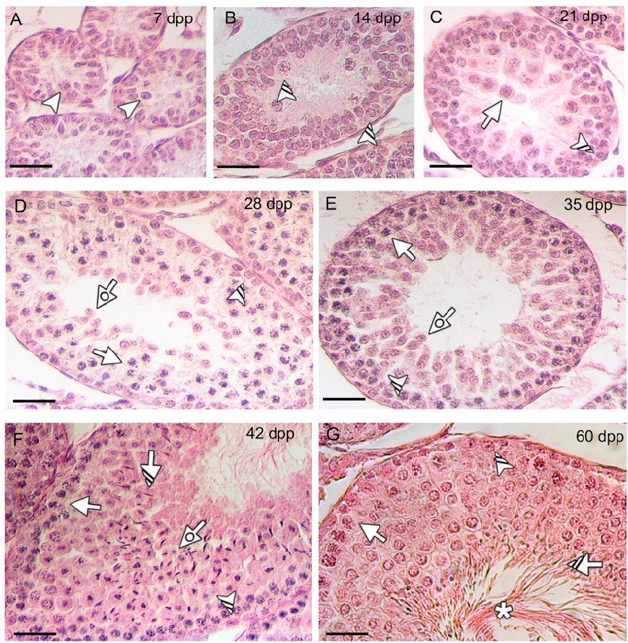
(Figure 4G–I), the protein retained its localization in SPC (arrow; Figure 4I) and rSPT (dotted arrow; Figure 4I and inset).